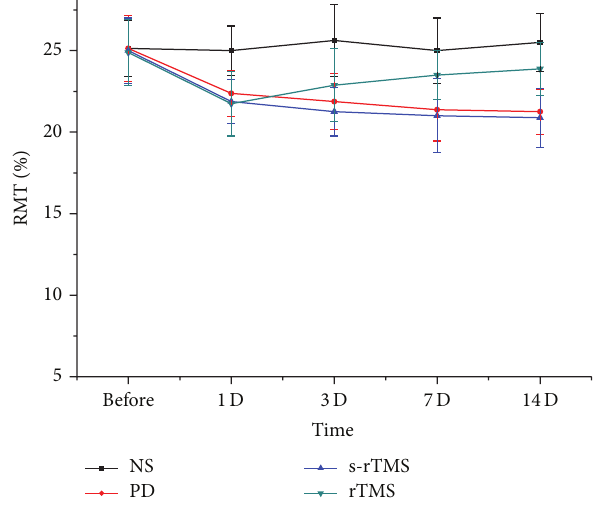
Figure 3: The comparison of RMT of mice in different groups at different time points.